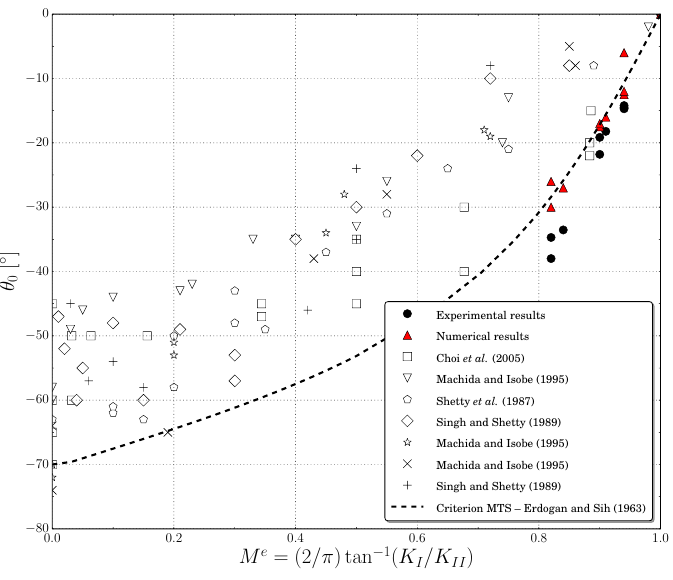
Figure 15. Comparative analysis of the initial crack inclination angle as a function of the mixed fracture